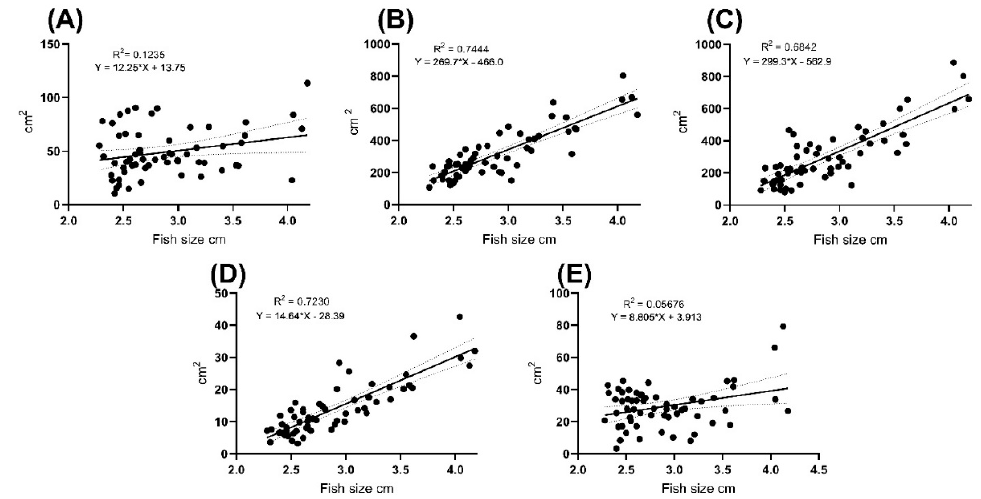
Figure 4. Linear regression of MoGV and MeGV parameters as a function of male N. guentheri size. ( A ) BROI linear regression; ( B ) LBRIO linear regression; ( C ) RROI linear regression; ( D ) BBCF linear regression; ( E ) RSGC linear regression.